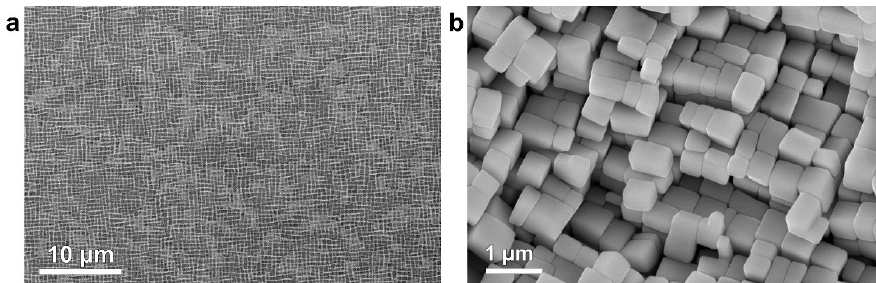
Figure 7. Micrographs showing a typical γ / γ΄ two-phase structure. ( a ) Low magnification backscattered electron (BSE) image showing that the microstructure is uniform; ( b ) three-dimensional structure of γ΄ precipitates in Ni-based single crystal superalloy.